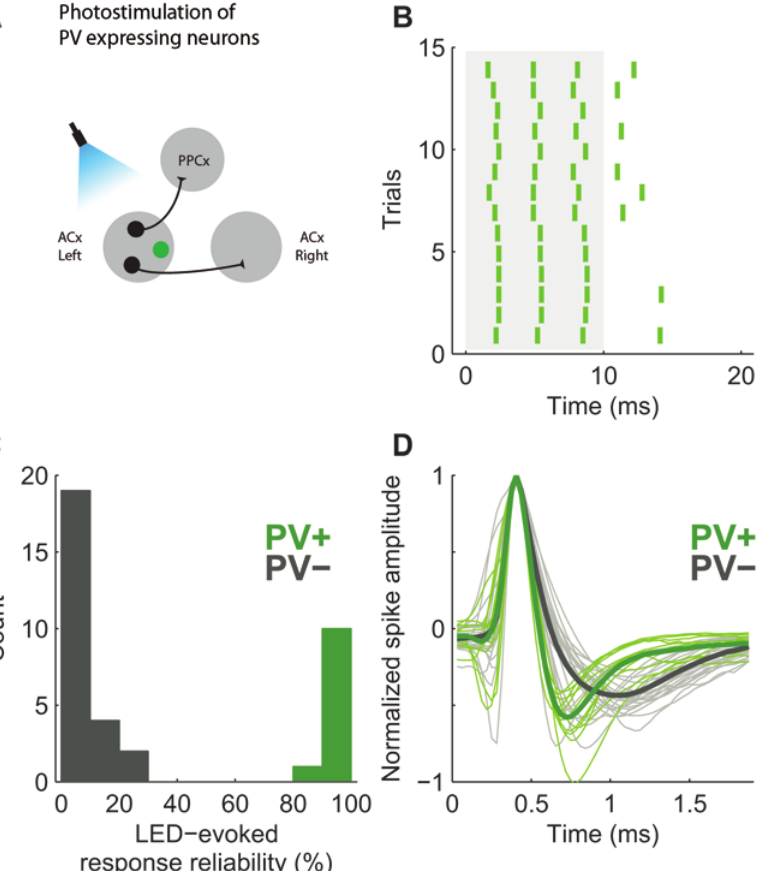
Figure 4. In vivo photostimulation of parvalbumin expressing auditory cortex neurons. (A) PV expressing neurons in the mouse auditory cortex, labeled with the binary Cre-AAV system, were tagged with ChR2 (green). (B) Spike rasters of a well isolated single unit that responded to light activation in the mouse auditory cortex. Light was on from 0 to 10 ms. (C) Reliability of light-evoked responses in all the cells recorded in the mouse auditory cortex. Reliability was computed as the fraction of trials in which the firing rate within the 40 ms after the start of the light pulse was greater than within the 40 ms immediately preceding the light pulse. (D) Action potentials originated from ChR2-expressing neurons were narrower than spikes originated from the rest of the population ( green - ChR2 positive, gray – unlabeled